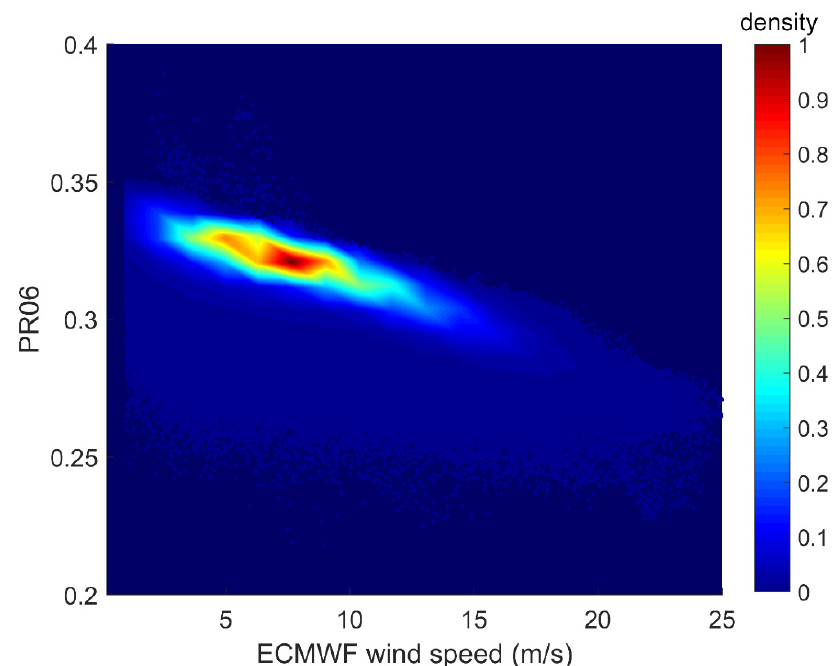
Figure 3. PR06 from SMR versus wind speed from ECMWF.